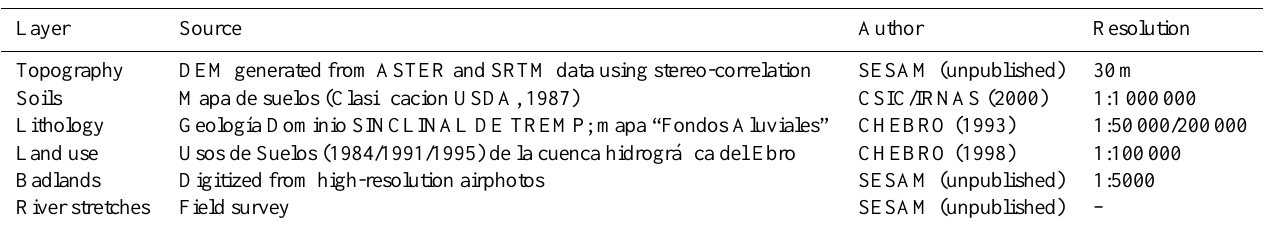
Table 5. Geospatial data sources for Isbena case